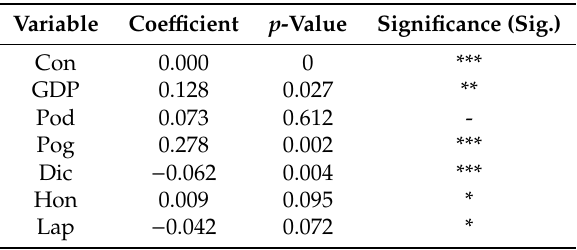
Table 2. Results of ordinary least squares (OLS).